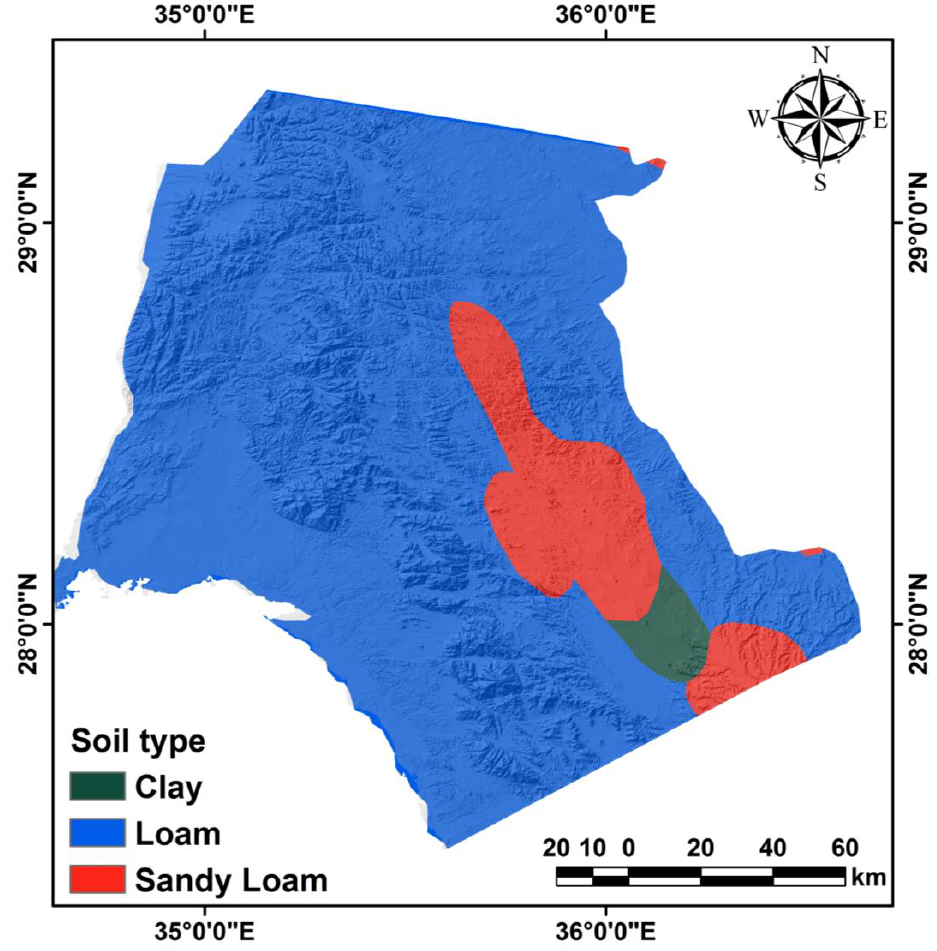
Figure 9. Map of the distribution of the three soil types in Neom: clay, loam, and sandy loam. Clay and sandy loam were detected in the eastern and southeastern regions, whereas the remainder of the area had loam soil. Table 1. Showing the eight layers used in the overlay analysis to find potential groundwater zones and their influences, classes, and scales.